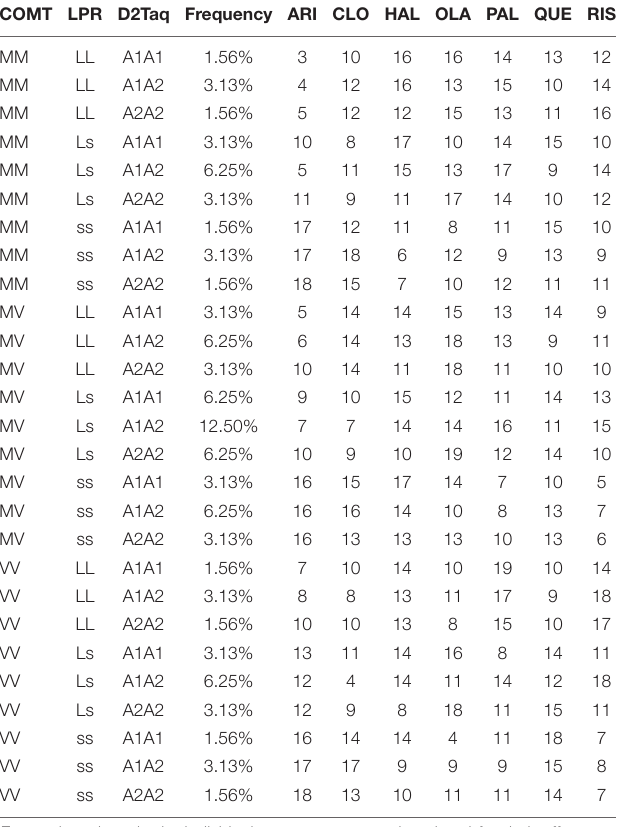
For each antipsychotic, individual genotypes are rank ordered for their effects on clinical outcome for efficacy and side-effects. After adding up these rank orders for the three outcomes, one can identify the antipsychotic for each genotype with the lowest rank order and therefore the best overall clinical response. These are shown in yellow. Aripiprazole is the medication that is best for the largest number of genotypes (10) but tied with clozapine for the MV/Ls/A1A2 (the largest group of subjects) and VV/ss/A1A2 combinations. Clozapine and risperidone each are the best choice for six genotypes, Haloperidol and olanzapine for 3 genotypes and quetiapine and paliperidone for one